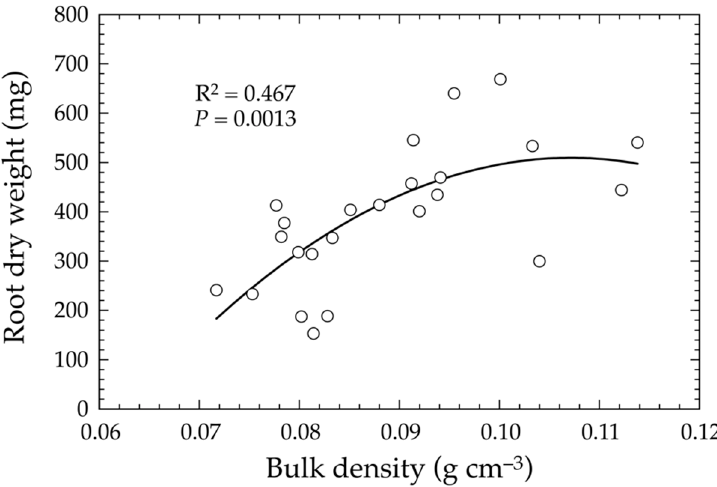
Figure 6. Relationship between root dry weight of white spruce seedlings (1+0) and bulk density of substrates at the end of the growing season ( n = 24). Table 4. Pearson correlation coe ffi cients 1 between morphological variables and physical and chem- ical properties of forest nursery substrates after po tt ing, quantities of nitrogen (N total ), phosphorous (P) and potassium (K) applied per seedling of white spruce (1+0) during the growing season and physical properties determined at the end of the growing season. Shoot DW 2